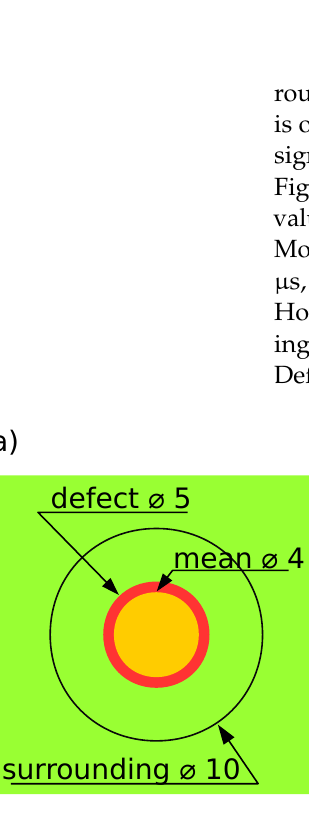
Figure 7. Schematic of the collected pixels for an artificial defect and its surrounding, and A-scan graph of Defect-1.0 and its surrounding in Band1: ( a ) Description of the range of a defect and its surrounding for the measured values, and ( b ) LDV signals of Defect-1.0 in the AL6061 specimen as a function of the measured time in